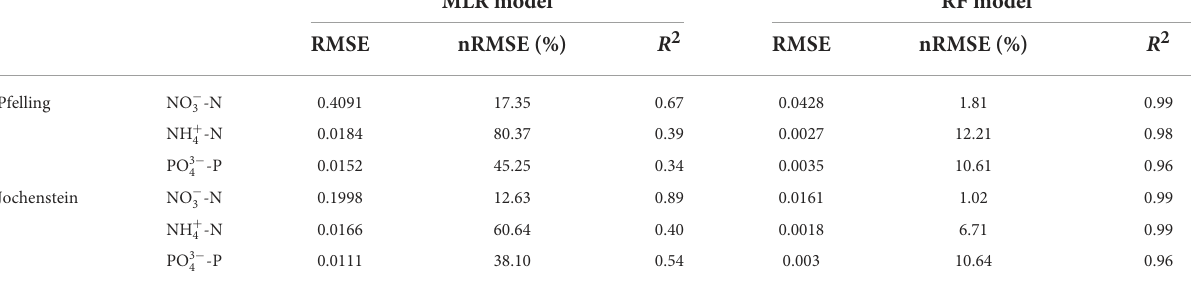
TABLE 8 Performance on testing